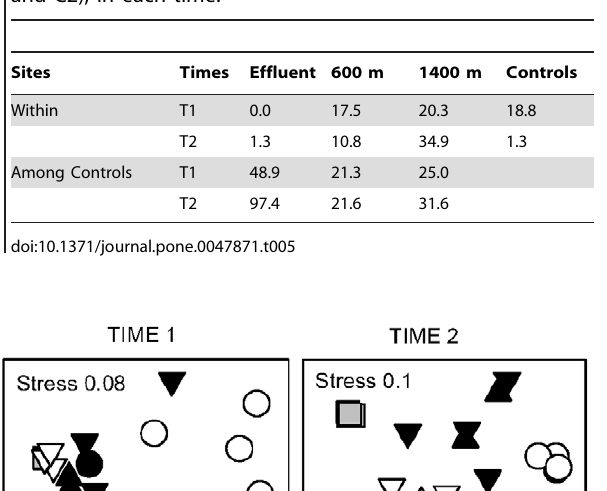
Figure 5). The comparison between the Effluent and the control sites showed a significant interaction between Distance and Time ( p , 0.05; for values of F , please refer to Table 6), with the Effuent